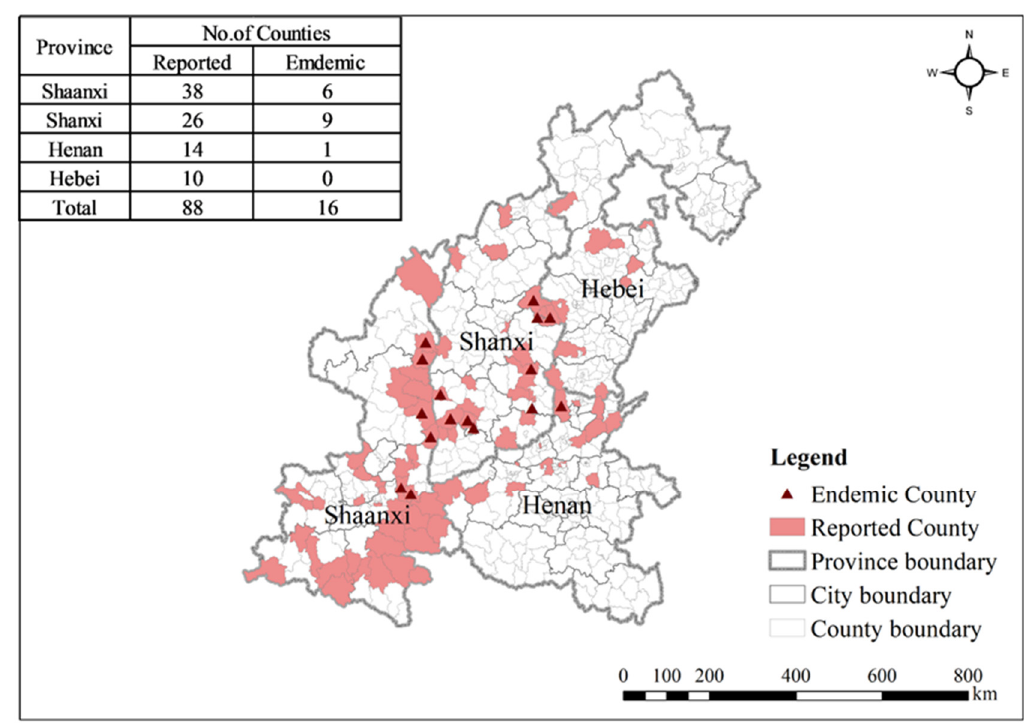
Figure 2. The spatial distribution of VL in central China from 2006 to 2019. Table 3. The temporal distribution of VL cases from 2006 to 2019 in central China. Shaanxi Shanxi Henan Hebei Year No. of Cases